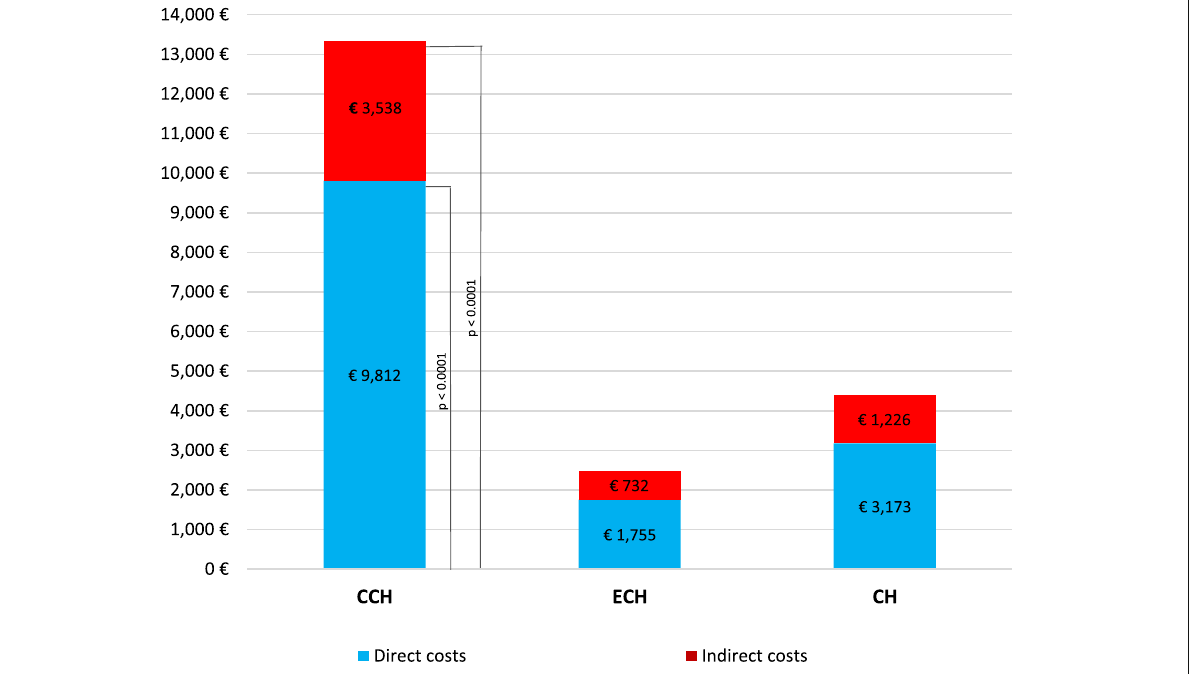
Fig. 4 Total costs per cluster headache